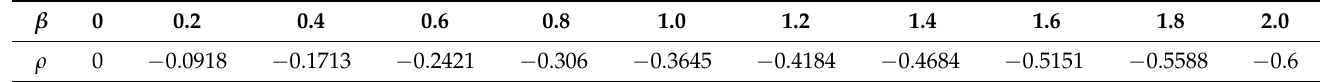
Table 6. Numerical values of ρ for α = 1/2 and β ∈ { 0,0.2, . . . ,1.8,2 }